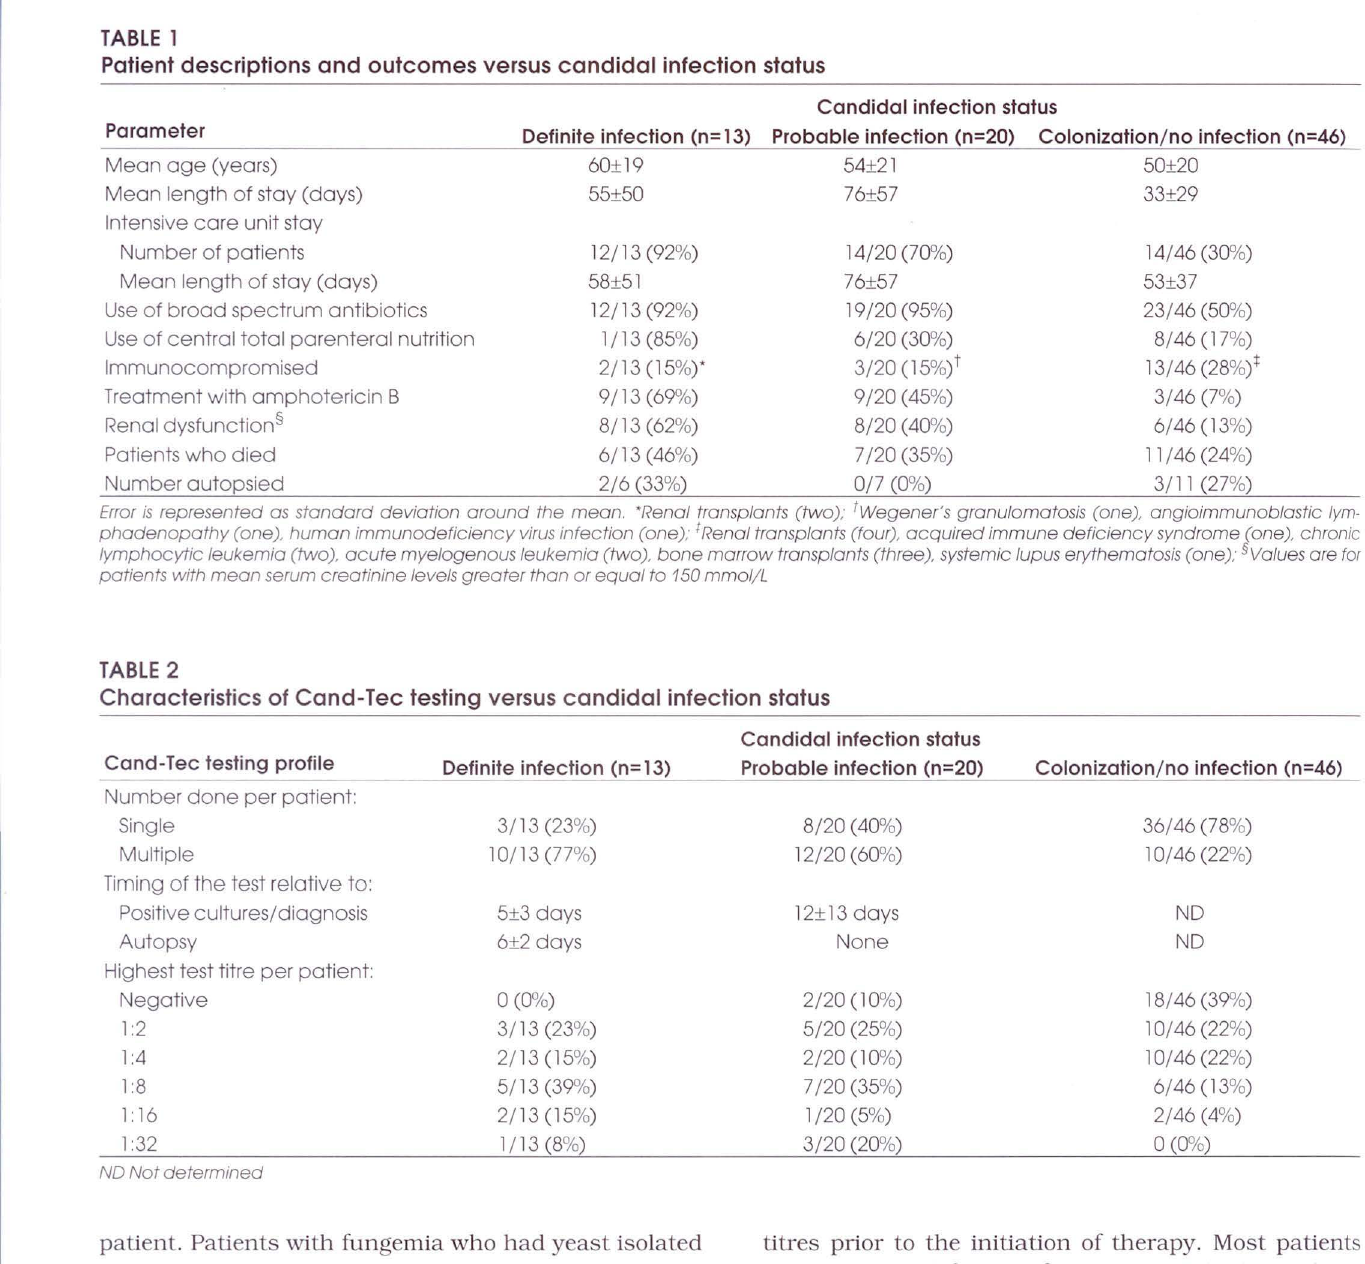
Candida! infection status